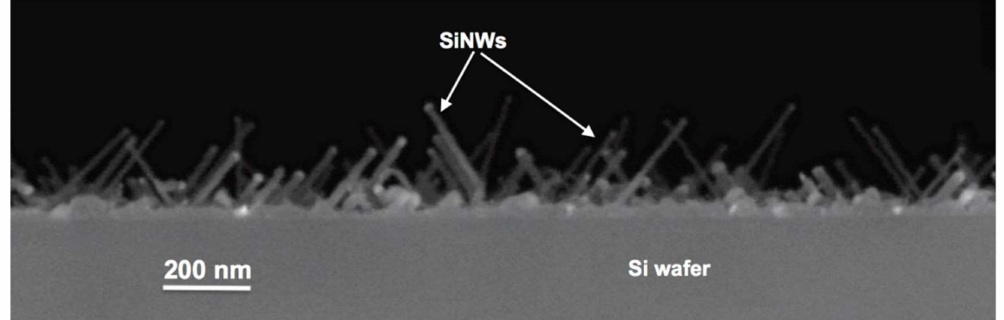
Figure 1. SEM micrograph in cross view of the as grown SiNWs array after the CVD deposition used as substrate for the AZO